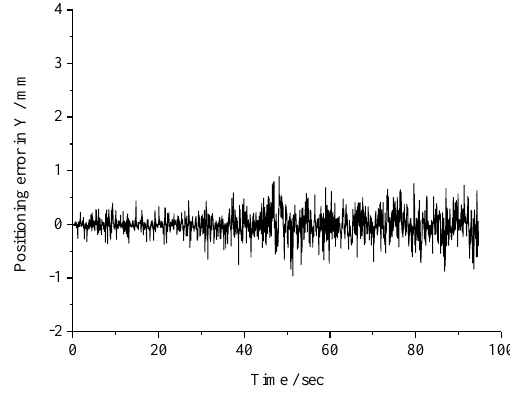
Figure 10. Positioning error of feed platform in Y .